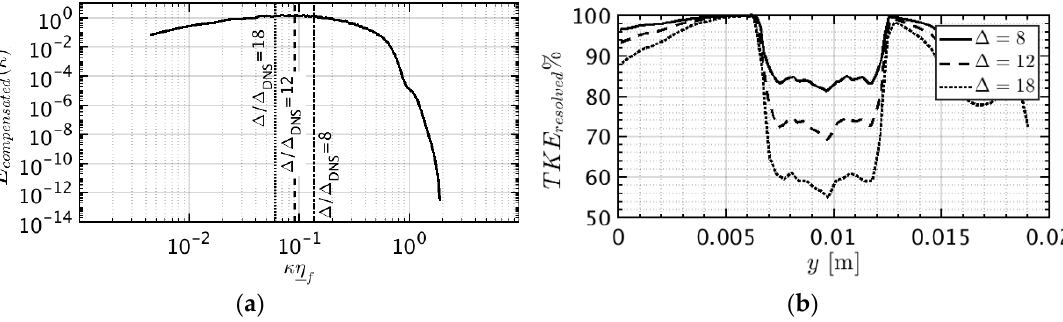
Figure 2. ( a ) Locations of the cutoff filter with the corresponding filter widths on log-log plot of compensated energy spectrum computed on the central plane; and ( b ) fraction of the Favre averaged resolved TKE using different filter widths at 𝑡 = 20𝑡 𝑗 .